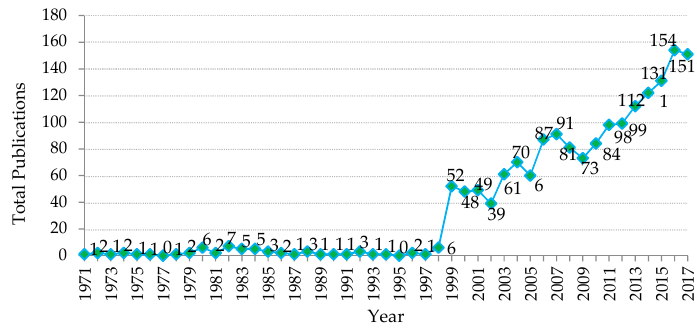
Figure 1. The distribution of publications of trace elements study in coal and ash